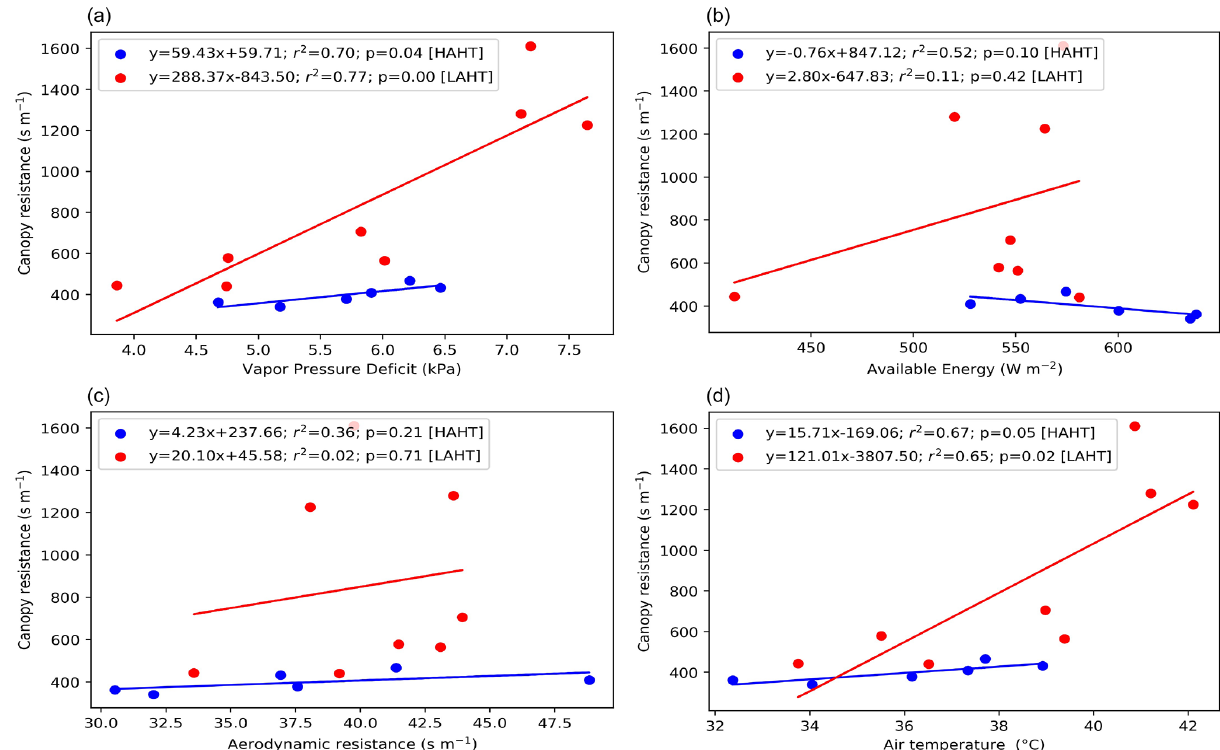
Figure 4. Linear correlation between daily midday average canopy resistance derived from the Penman–Monteith equation with (a) observed vapor pressure deficit (VPD). (b) Available energy at the surface. (c) Aerodynamic resistance. (d) Air temperature for the HAHT and LAHT